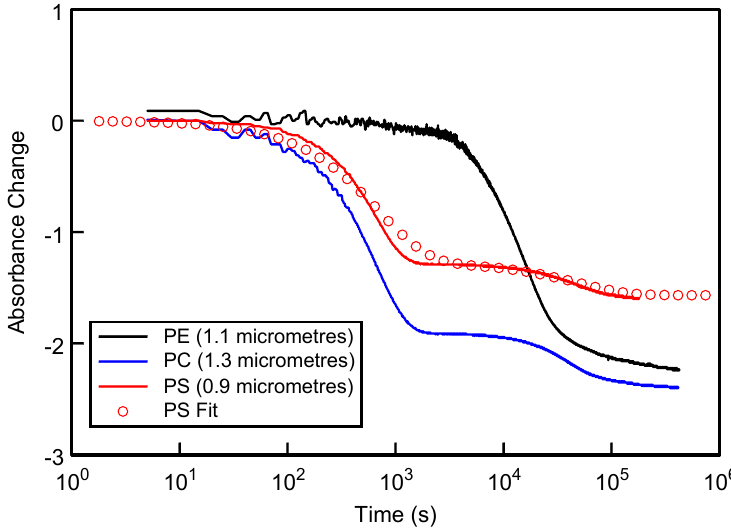
Figure 5. Absorbance kinetics in a series of 20% DEH doped polymer films. The open circles show the optimum fit of Equation (3) to the PS data using the parameters given in Table 1. Note that in applying Equation (3) the modified expression P’(t) from Equation (4) has been used as outlined in the main text.